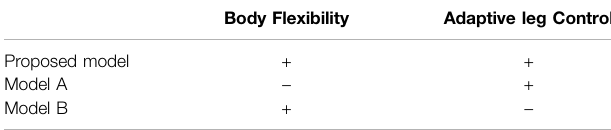
TABLE 3 | Characteristics of the models used for comparison. Body